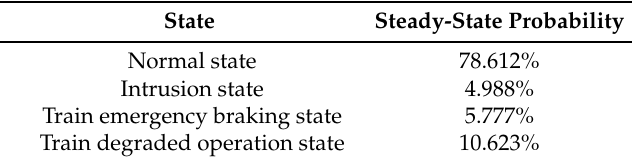
Table 9. Steady-state probability of CBTC